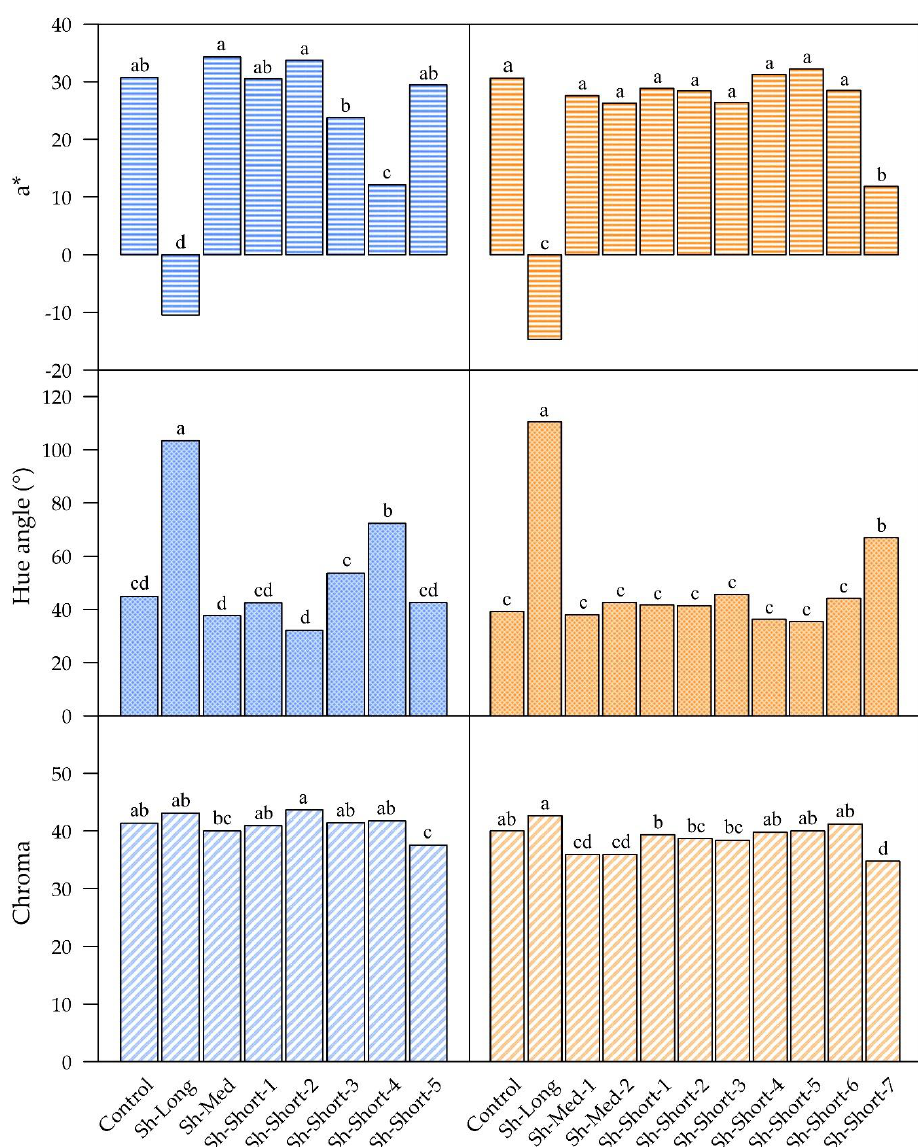
Figure 4. Means of a*, hue angle and chroma for “ANP-0118” at harvest (119 DAFB) and for “ANP-0131” at harvest (175 DAFB). Letters indicate means separation by Fisher’s LSD at 5% level of significance. The shading treatments a ff ected blush chroma in both cultivars by increasing its value during shaded periods, except for the last “ANP-0118” short shading treatment (Sh-Short-5) which showed a decrease from 41.8 to 37.6 from 113 to 119 DAFB (Figure 5). In addition, the last two “ANP-0131” short shading treatments (Sh-Short-6 and Sh-Short-7), while not decreasing in chroma value during shading, increased their value during shading at a lower rate compared to the control and other exposed treatments. In the earlier shading treatments (“ANP-0118” treatments Sh-Med, Sh-Short-1 and Sh-Short-2; “ANP-0131” treatments Sh-Med-1, Sh-Med-2, Sh-Short-1 and Sh-Short-2), re-exposure to sunlight following shading coincided with a significant decrease in chroma value (Figure 5). Later shaded “ANP-0118” Sh-Short-3 and Sh-Short-4 fruits showed no significant changes in their chroma values in response to re-exposure at 93 and 113 DAFB, respectively. The last short shading treatments prior to harvest in both cultivars (“ANP-0118” Sh-Short-5 and “ANP-0131” Sh-Short-7) and both medium “ANP-0131” shading treatments (Sh-Med-1 and Sh_med-2) ended with a significantly lower chroma value than the